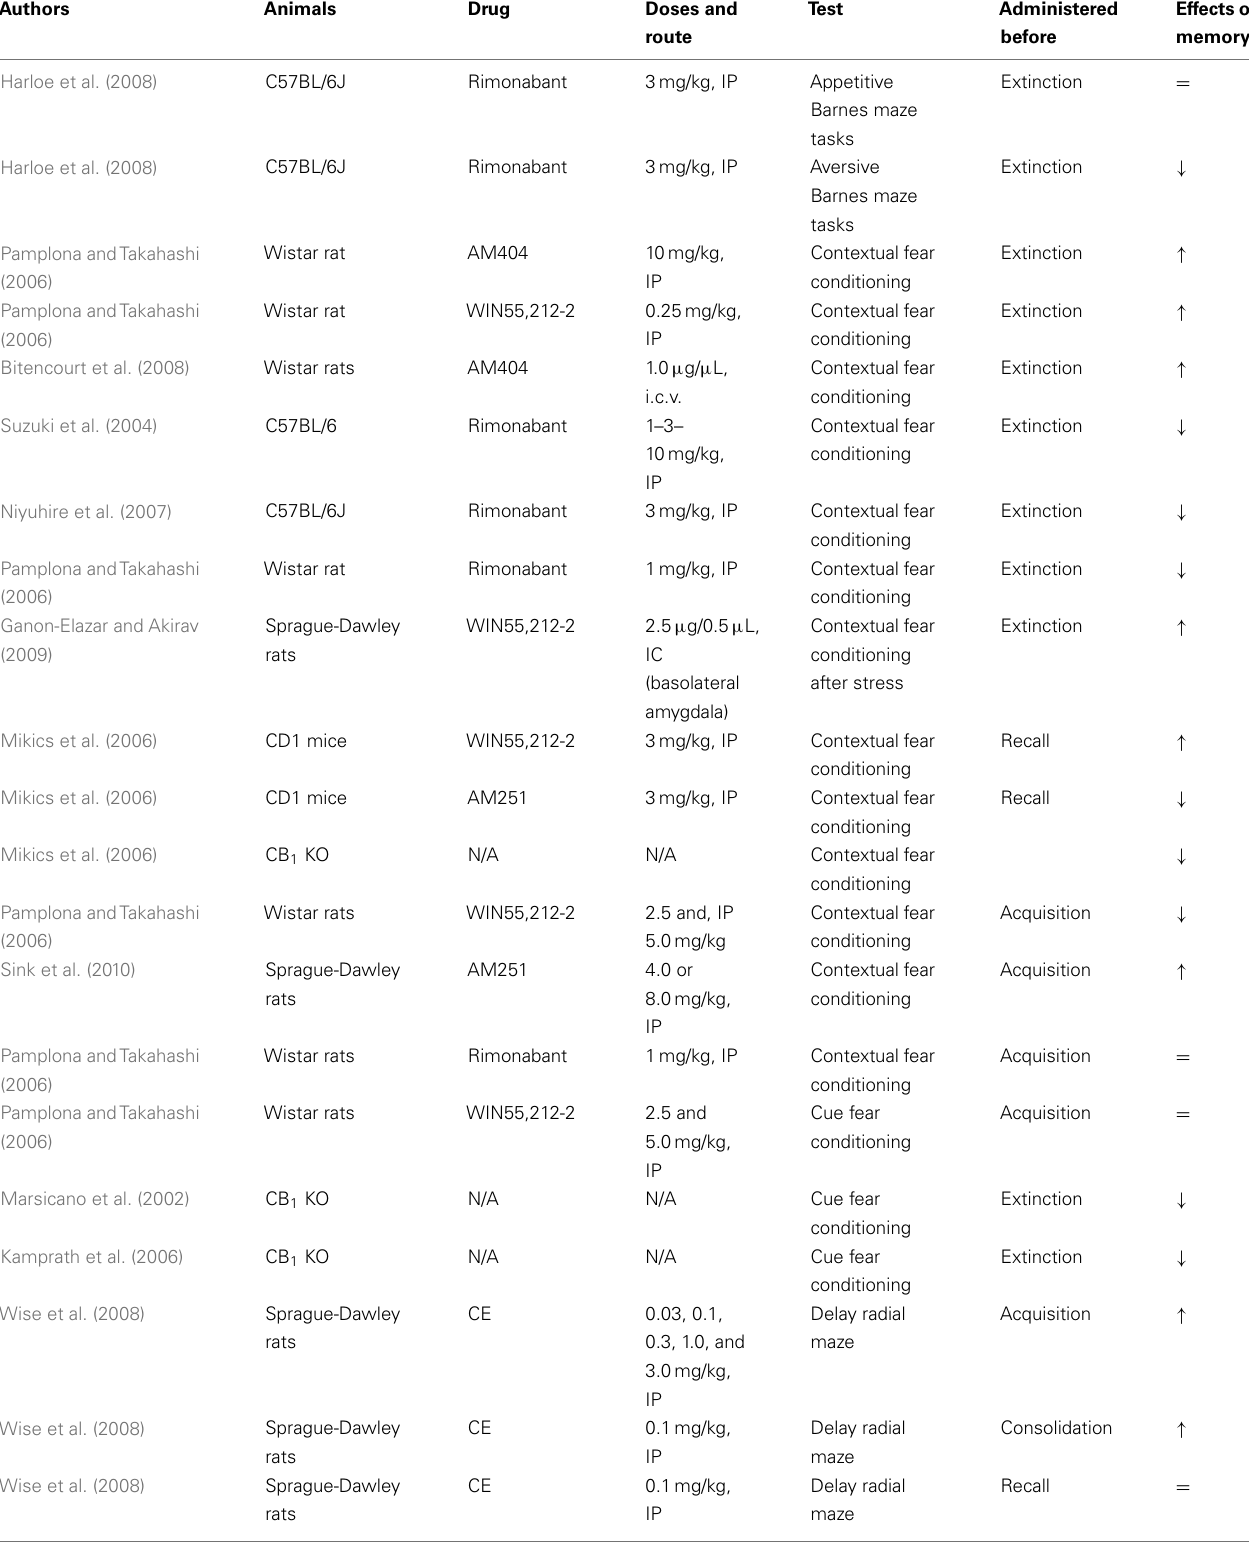
Table 1 | Summary of studies investigating the effects of cannabinoid receptor agonists, cannabinoid receptor antagonists, FAAH inhibitors, or genetic deletion of cannabinoid receptors on learning and memory in